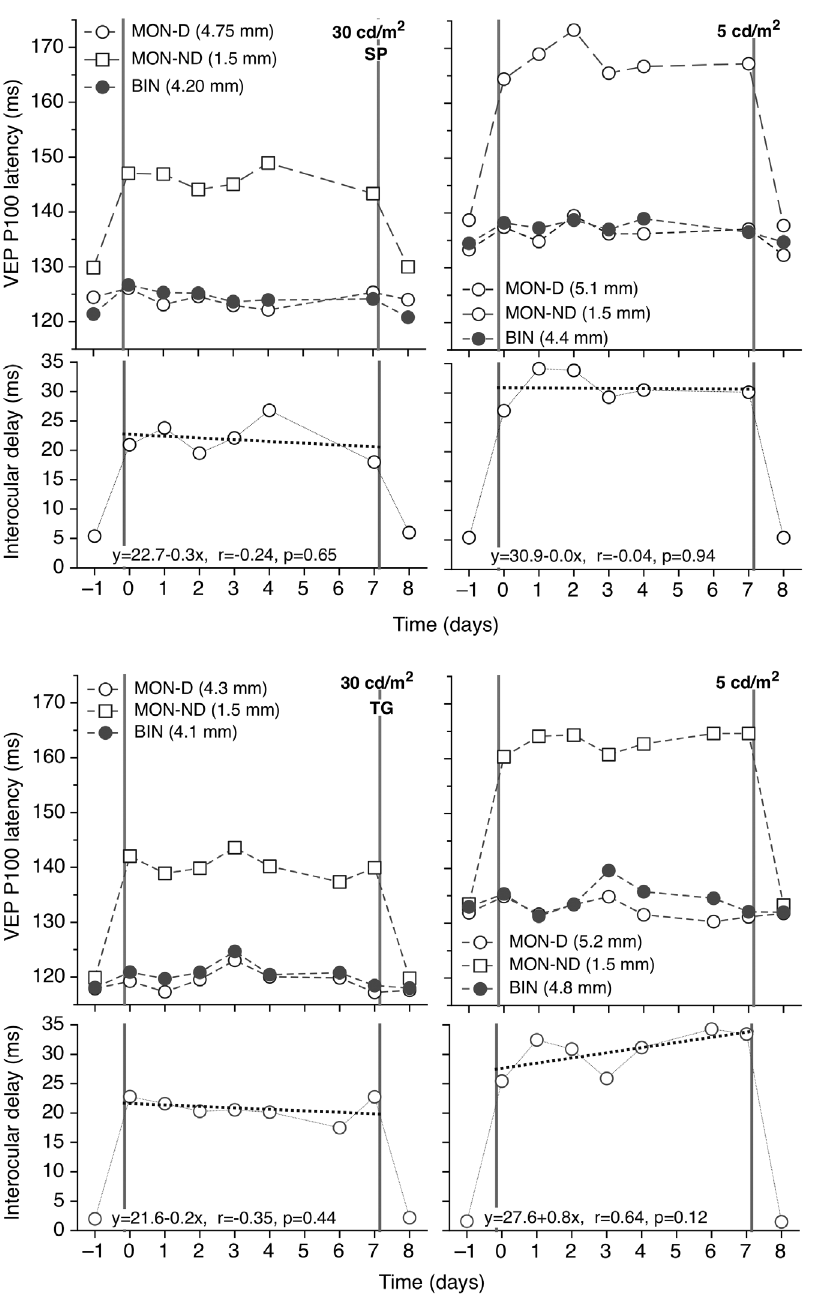
Figure 3. Plots of VEP latency as a function of time for the 1.5 mm aperture contact lens. (upper) Plots of monocular (open circles, dominant eye; open squares, non-dominant eye) and binocular (filled circles) mean latency of the VEP P100 component as a function of time at high (left) and low (right) photopic levels for subjects SP (fig 3a) and TG (fig 3b). Each point is the average of two recordings. On days -1 and 8 the subject had unobstructed natural pupils. On days 0–7 inclusive the non-dominant (left) eye was wearing a contact lens with an aperture of 1.5 mm in diameter. The dominant eye had its full, unobstructed natural pupil. The legend shows the average pupil size at each condition. (lower) Plot of the interocular latency difference as a function of time. The dotted bold line forms a linear regression for Days 0 to 7. pupil diameter values recorded during the Pulfrich experiment, the experiment reduces the total amount of light reaching the are shown in Table 2. Fig.6 shows that, in general, observed ND retina and causes a dilation in the natural pupil which increases values are higher than the predicted ND values, an effect which is with the ND value, although constant retinal illuminance is not maintained. This tends to increase the observed null ND value in more pronounced with the larger artificial pupil. This discrepancy may be due to the nature of the Pulfrich experiment. Placing ND comparison with that predicted on the basis of an average natural filters in front of the dominant eye (having a natural pupil), during pupil diameter. Moreover, when the artificial pupil is larger, and